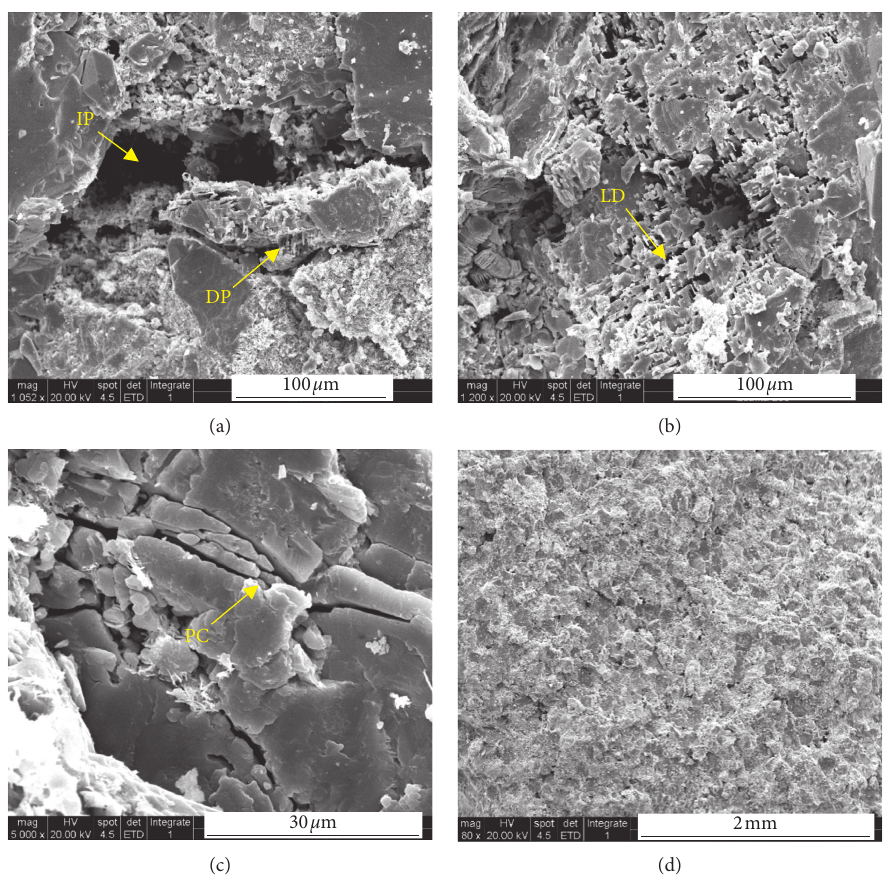
Figure 5: Pore types of Chang 2 reservoir in the study area. (a) Residual intergranular pores (IP) and dissolution pores (DP) (Z140, 1473.4m); (b) particle leaching dissolution pores (LD) (Z140, 1473.4m); (c) particle cracks (PC) (Z140, 1473.9m); (d) overall, poor pore development (Z140,